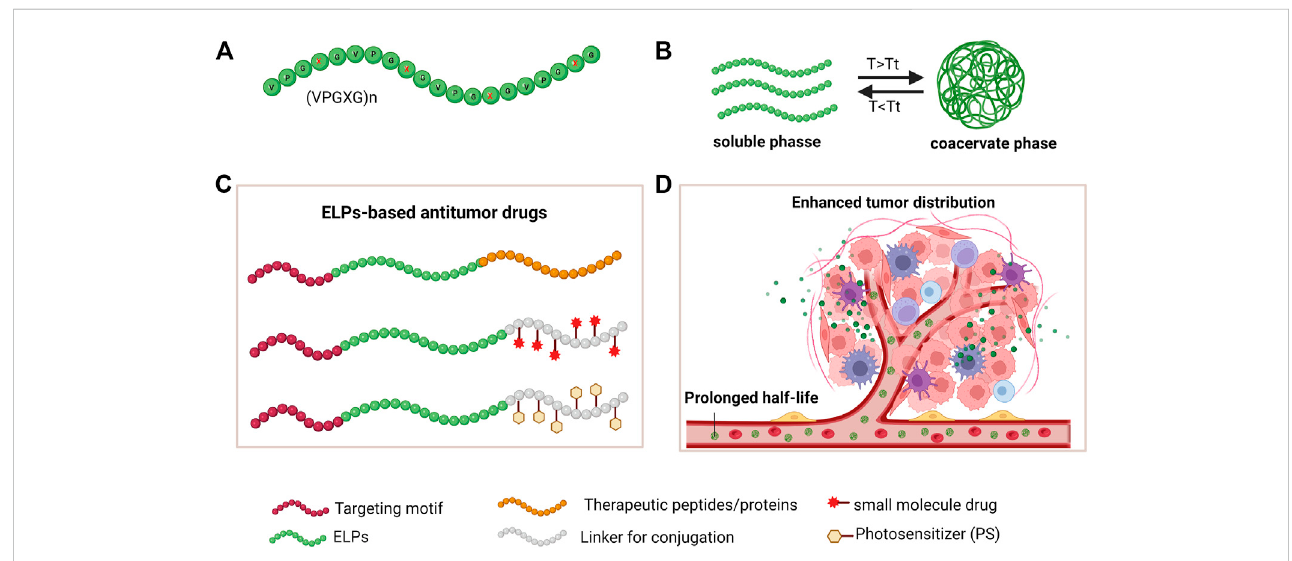
FIGURE 1 The ELPs properties and strategies of developing ELPs-based antitumor drugs. (A) amino acid sequence of ELPs; (B) The inverse transition cycling (ITC) property; (C) Strategies of developing drug-loaded ELPs by fusion expression and drug conjugation; (D) Schematic illustration of ELPs-based drugs in systemically circulating and tumor